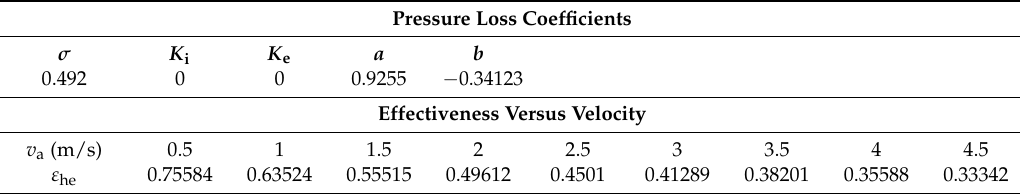
Table 2. Pressure drop and heat transfer parameters in heat exchanger